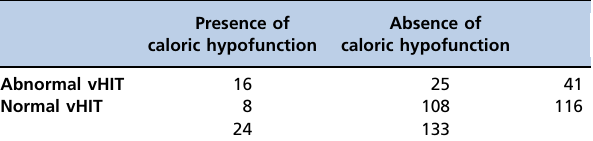
Table 2 - CT hypofunction compared with abnormal gain in the vHIT.